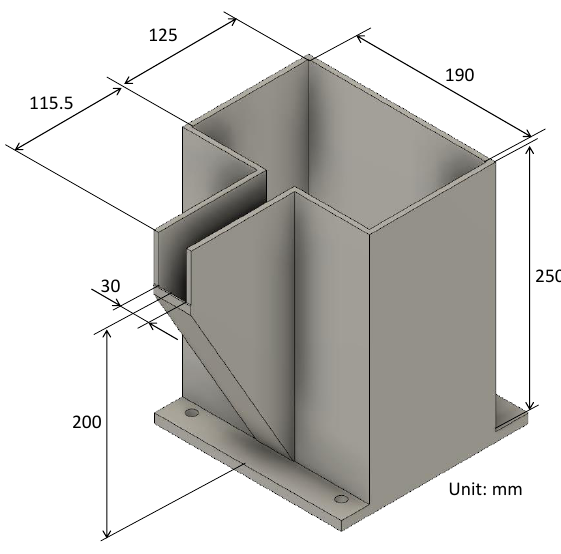
Figure 2. Shape of ladle used in this study.